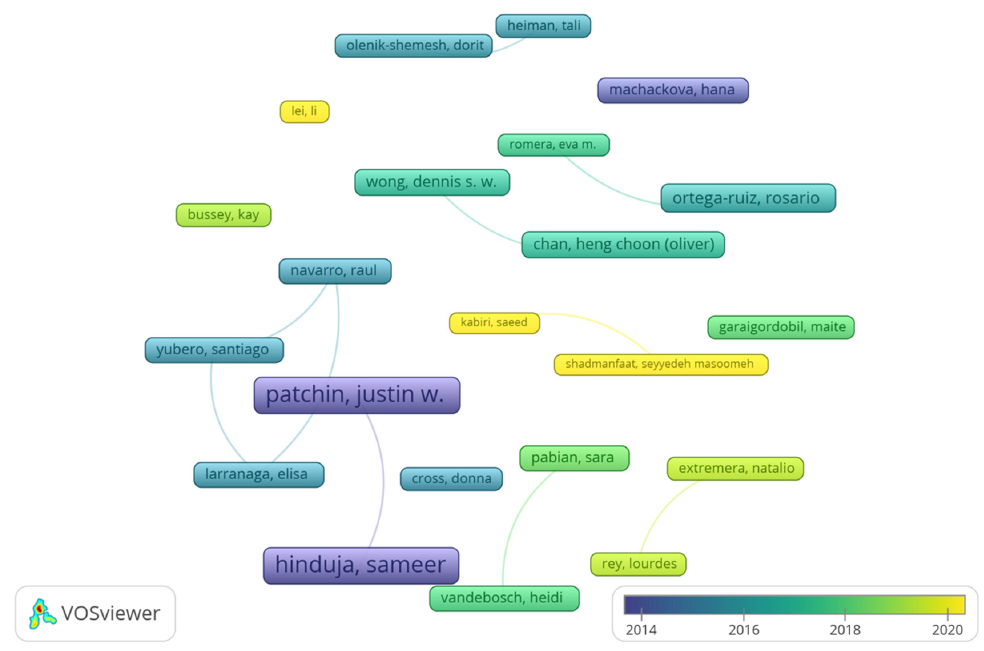
Figure 2. Graph with the most relevant co-authors: size node (citations) and colour (average publica- tion